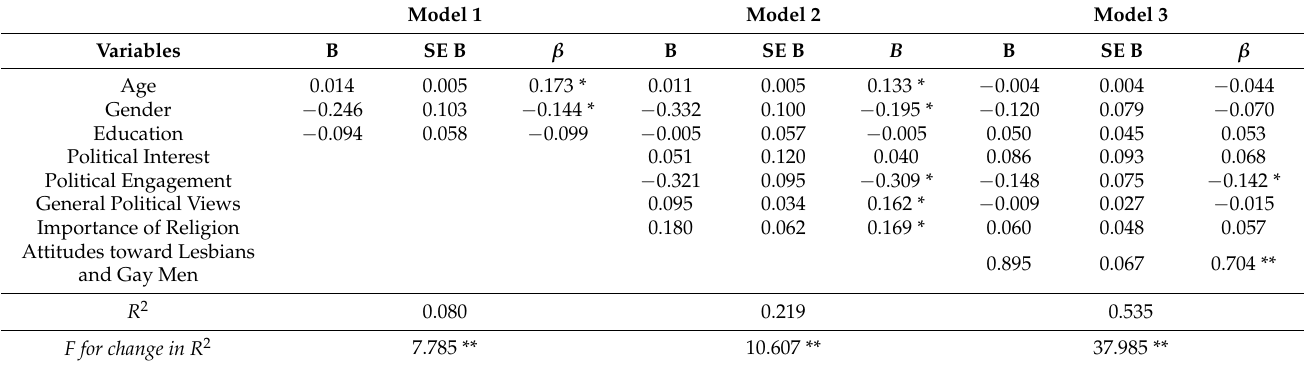
Table 9. Hierarchical multiple regression analysis predicting sexual